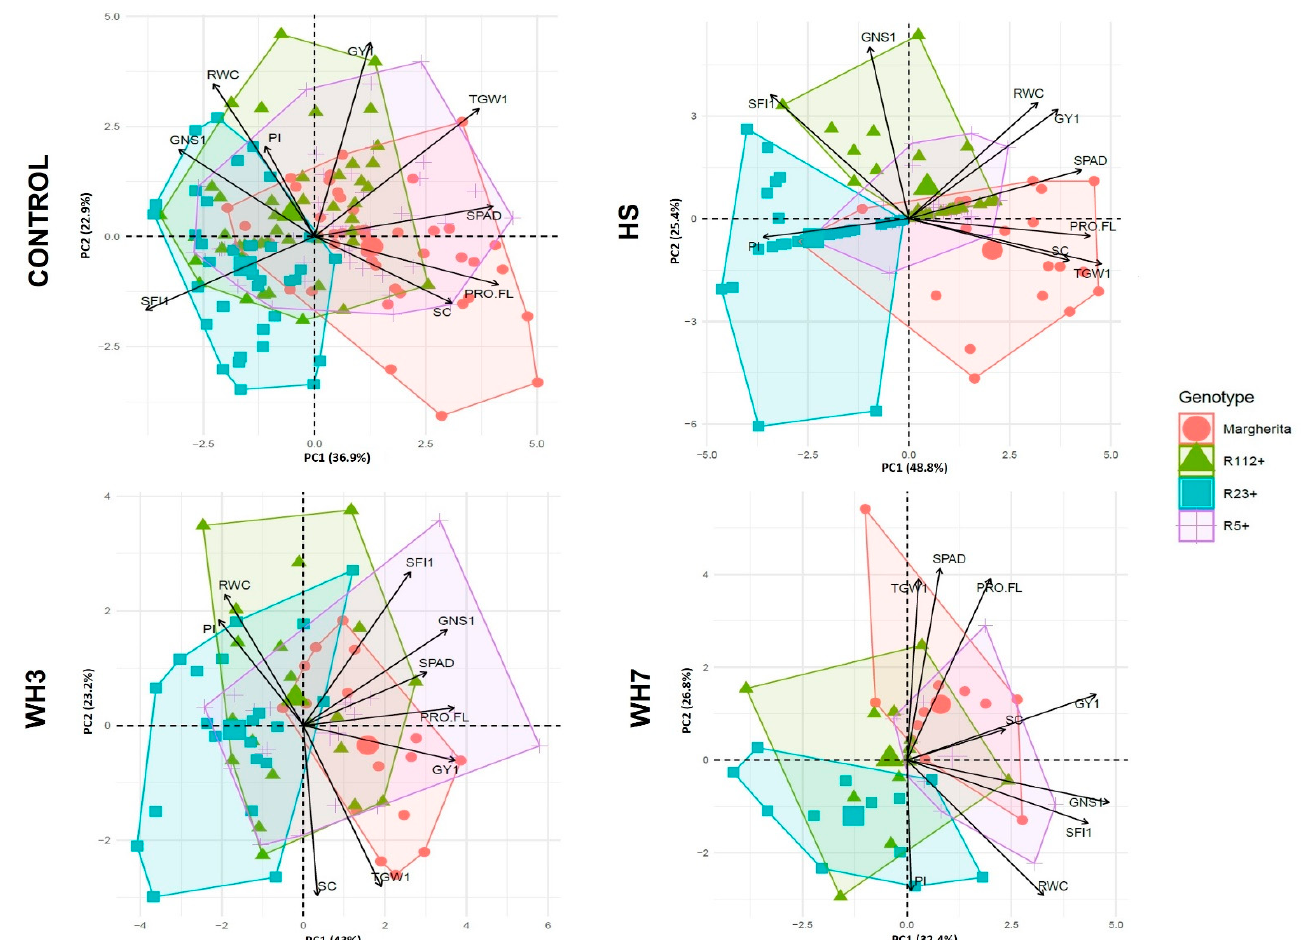
Figure 8. Principal component analysis (PCA) for physiological and yield parameters of the main culms of the three NIRLs+ and cv. Margherita, in control and three stress conditions, i.e., heat stress (HS), water-deficit + 3-day heat stress (WH3) and water-deficit + 7-day heat stress (WH7). The acronyms of the vectors correspond to traits described in the Materials and Methods section.